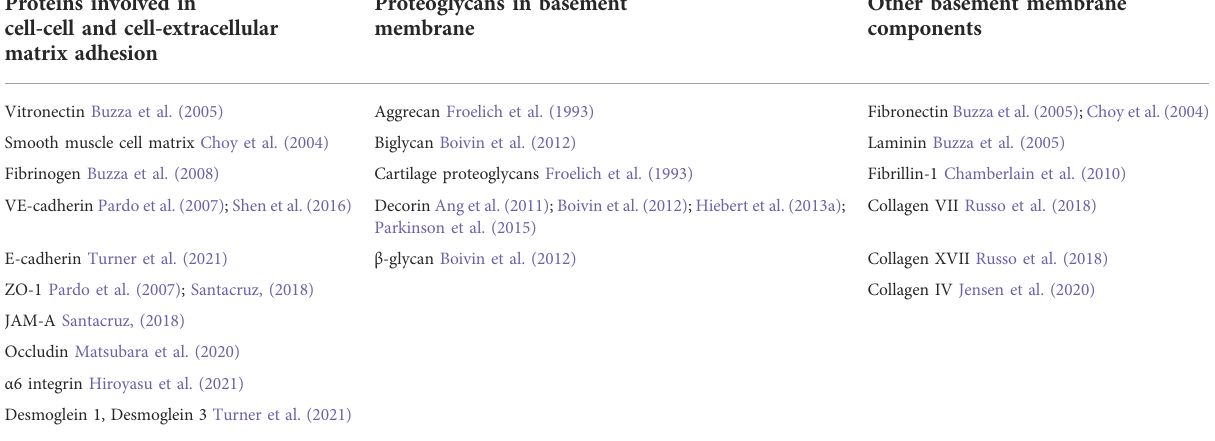
Table of cell-cell and cell-extracellular matrix adhesion proteins, as well as proteoglycans, which act as substrate for